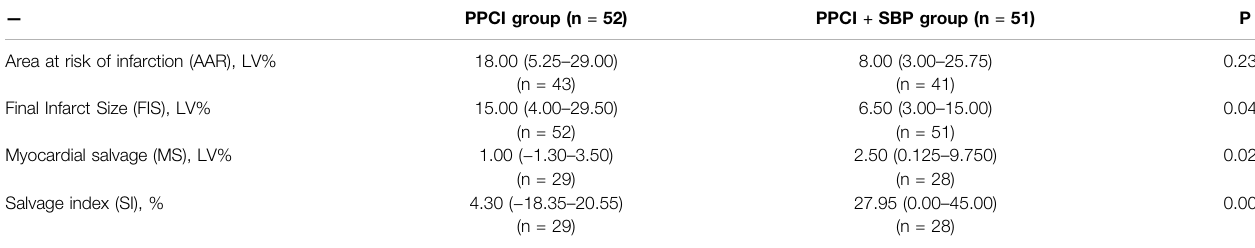
TABLE 4 | Myocardial I/R injury and Final infarct size assessed by SPECT. — Area at risk of infarction (AAR), LV%